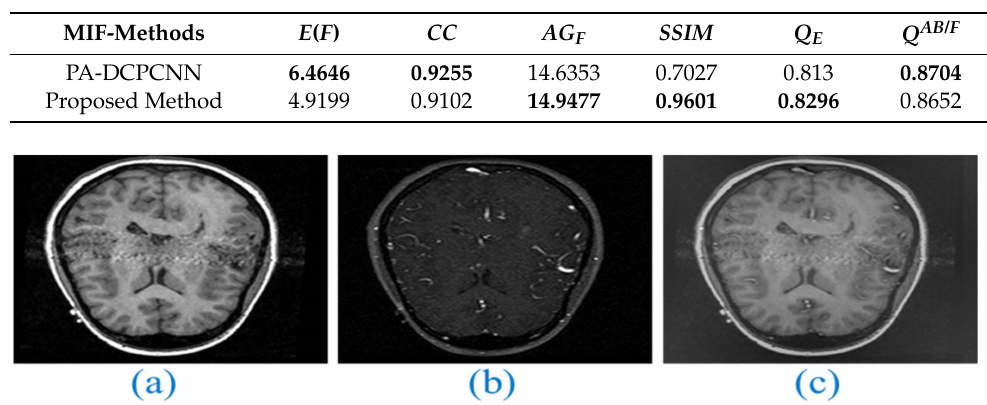
Table 13. The results and comparisons for medical image ([20]).